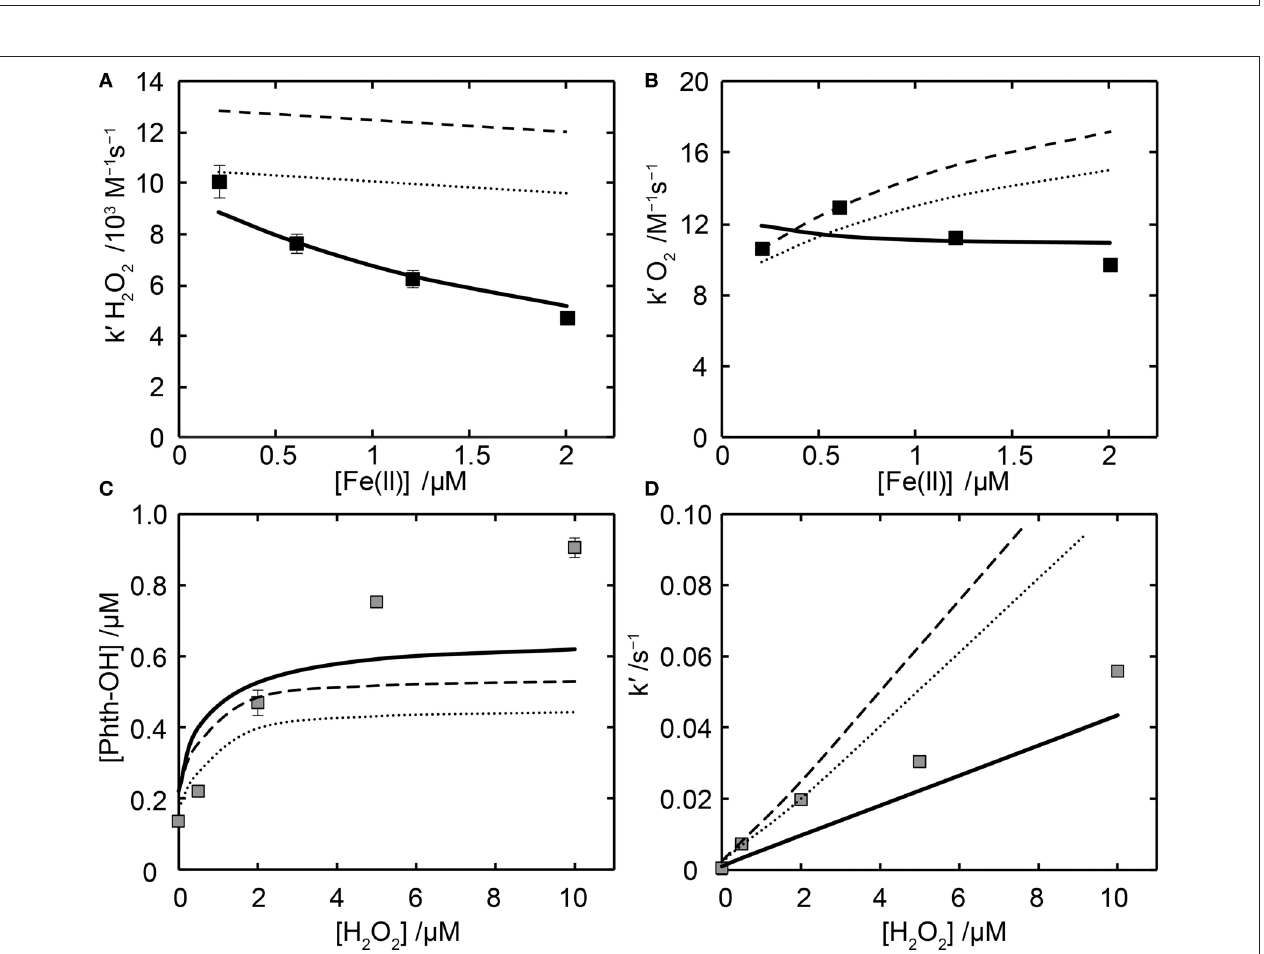
FIGURE 4 | Kinetics of Fe(II) oxidation and resulting Phth-OH production in the presence of citrate. Panels (A,B) show the apparent rate constants for Fe(II)-citrate oxidation by (A) H 2 O 2 and (B) O 2 as a function of initial Fe(II) concentration ([cit] = 1 mM in all cases). Symbols are derived from linear fits of experimental pseudo-first order oxidation rate constants as a function of [H 2 O 2 ] (A) or from the pseudo-first order rate constant divided by [O 2 ] (B) . Panels (C,D) show HO • production, with panel (C) showing the magnitude of total Phth-OH production when [Fe(II)] 0 = 2 µ M and panel (D) showing the kinetics of Phth-OH formation (the pseudo-first order rate constant of Phth-OH production). In all panels model predictions are indicated by lines, with the Fe(II)L model shown as a dashed line, the Fe(II)L-2 µ M model as a dotted line and the Fe(II) 2 L model as a solid line.